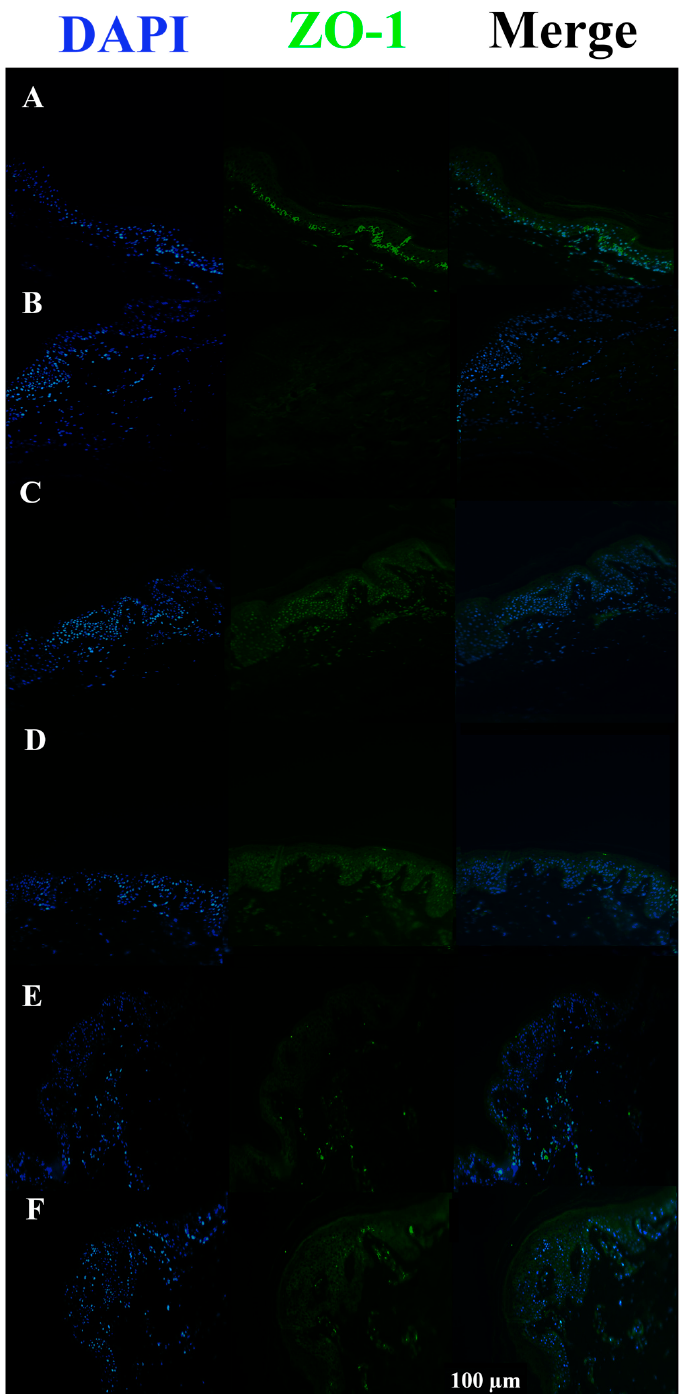
Figure 5. ZO-1 immunofluorescence on animal explant sections infected with S. aureus ATCC29213 live bacteria (20 × magnification). DAPI channel (461 nm, blue) is shown on the left side; Anti-ZO-1 antibody Alexa488 nm-conjugated is in the middle; merge images are shown on the right. Lane description. ( A ) Not infected tissues; ( B ) not treated infected tissues; ( C ) c40 pre-incubated infected tissues; ( D ) Hac40 pre-incubated infected tissues; ( E ): c40 co-incubated infected tissues; ( F ) Hac40 co-incubated infected tissues. The ZO-1 signal in Hac40 co-incubated tissues was almost comparable to the untreated control. Scale bar 100 µm.